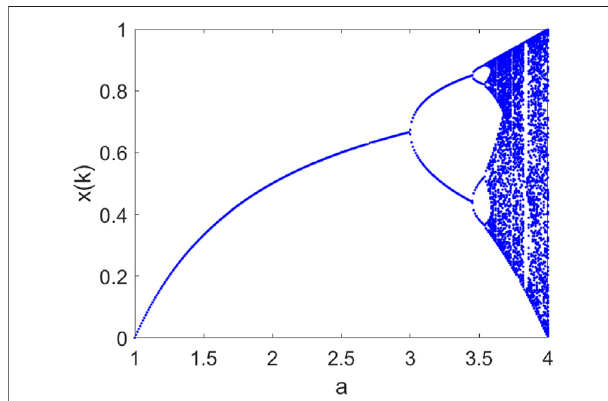
FIGURE2| BifurcationdiagramoftheIkedamapin Eq.3 withrespectto p . Other parameters: B = 0.76, ρ = 0.4, and a =